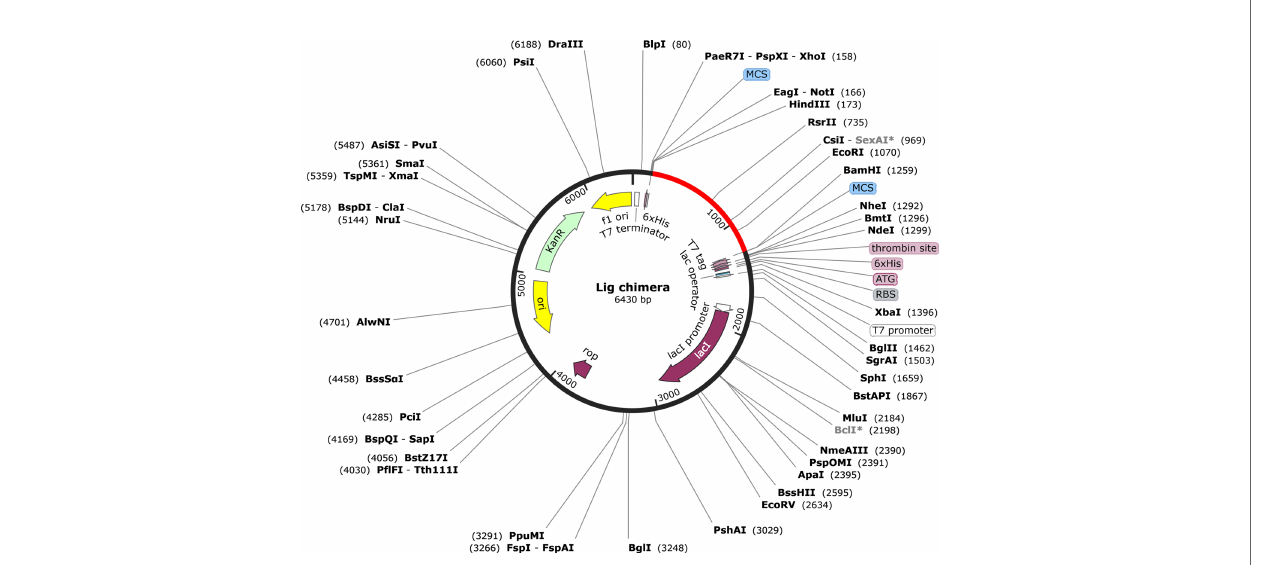
FIGURE 8 | Representation of the in silico cloning of the multi-epitope vaccine construct. The codon optimized gene sequence of the vaccine candidate (represented in red color) was cloned between the BamHI and HindIII restriction sites of the pET-28a(+) expression vector (shown as black